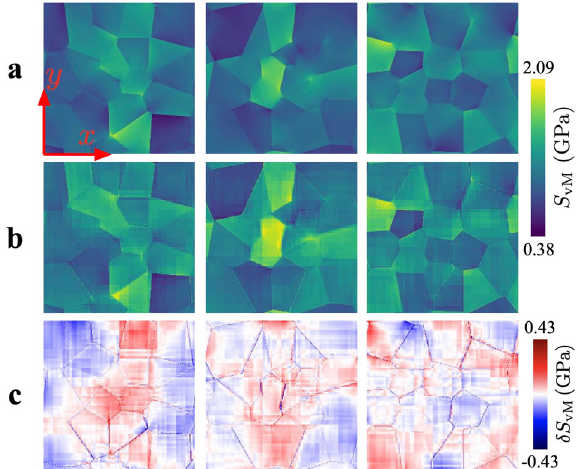
Fig. 1 Stress distribution in case of elastic material response. Simulation results obtained by DAMASK in conjunction with a spectral solver ( a ) and the corresponding AI predicted ( b ) von Mises stress distribution for three Voronoi tessellations of test micro- structures (not included in the training dataset) using the modi fi ed U-Net approach. The error, calculated as deviation between the two von Mises stress distributions, δ S vM , is shown in ( c ).